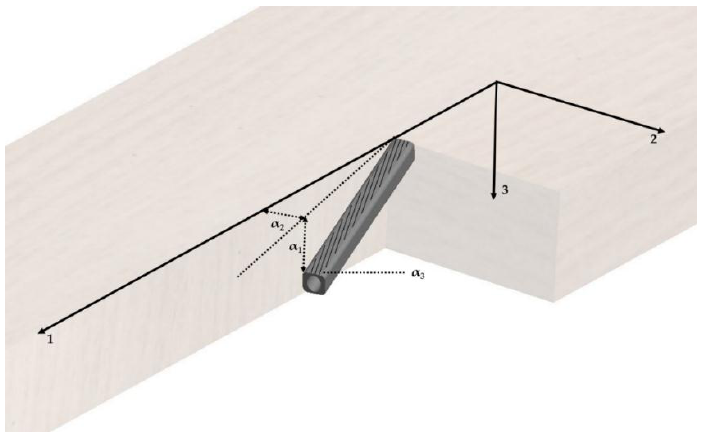
Figure 2. Possible deviations of the fiber within the wood and deviations of the fibrils within the fibers. α1 describes the angle between axis 1 (usually the longitudinal direction) and axis 3 (either tangential or radial direction). α2 describes the angle between axis 1 and axis 2 (either radial of tangential direction). α3 illustrates the deviation of the fibril from the fiber axis in the cell wall also known as micro fibril angle (mfa). [own depiction].